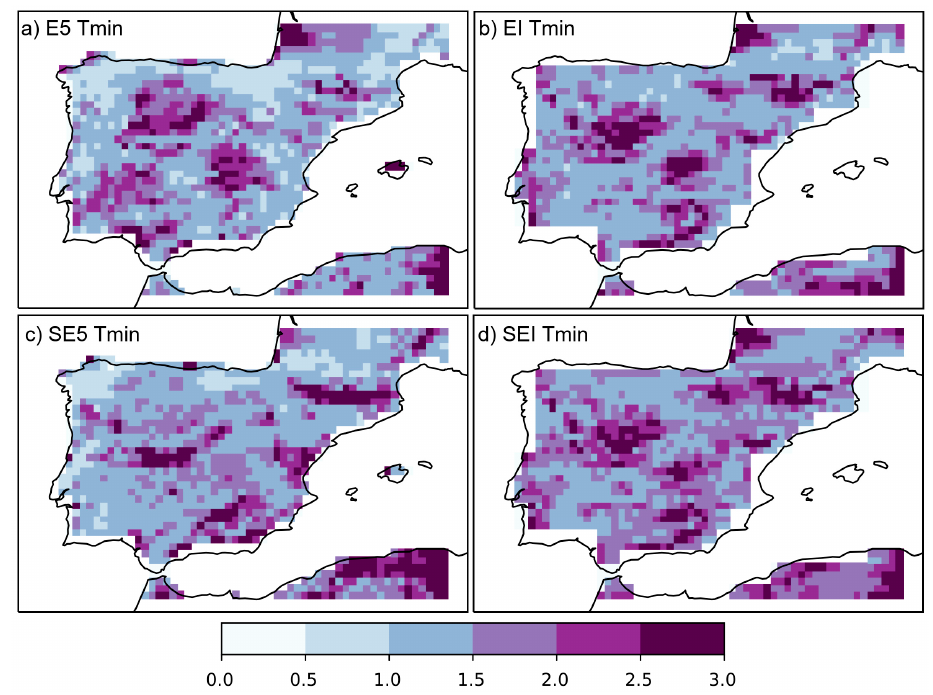
Figure 5. As Figure 4 but for the Tmin Root Mean Square Error (K) in: ERA5 ( a ), ERA-Interim ( b ) and the simulations forced with ERA5 ( c ) and ERA-Interim ( d ). Note the different range in the color bars with Figure 4.